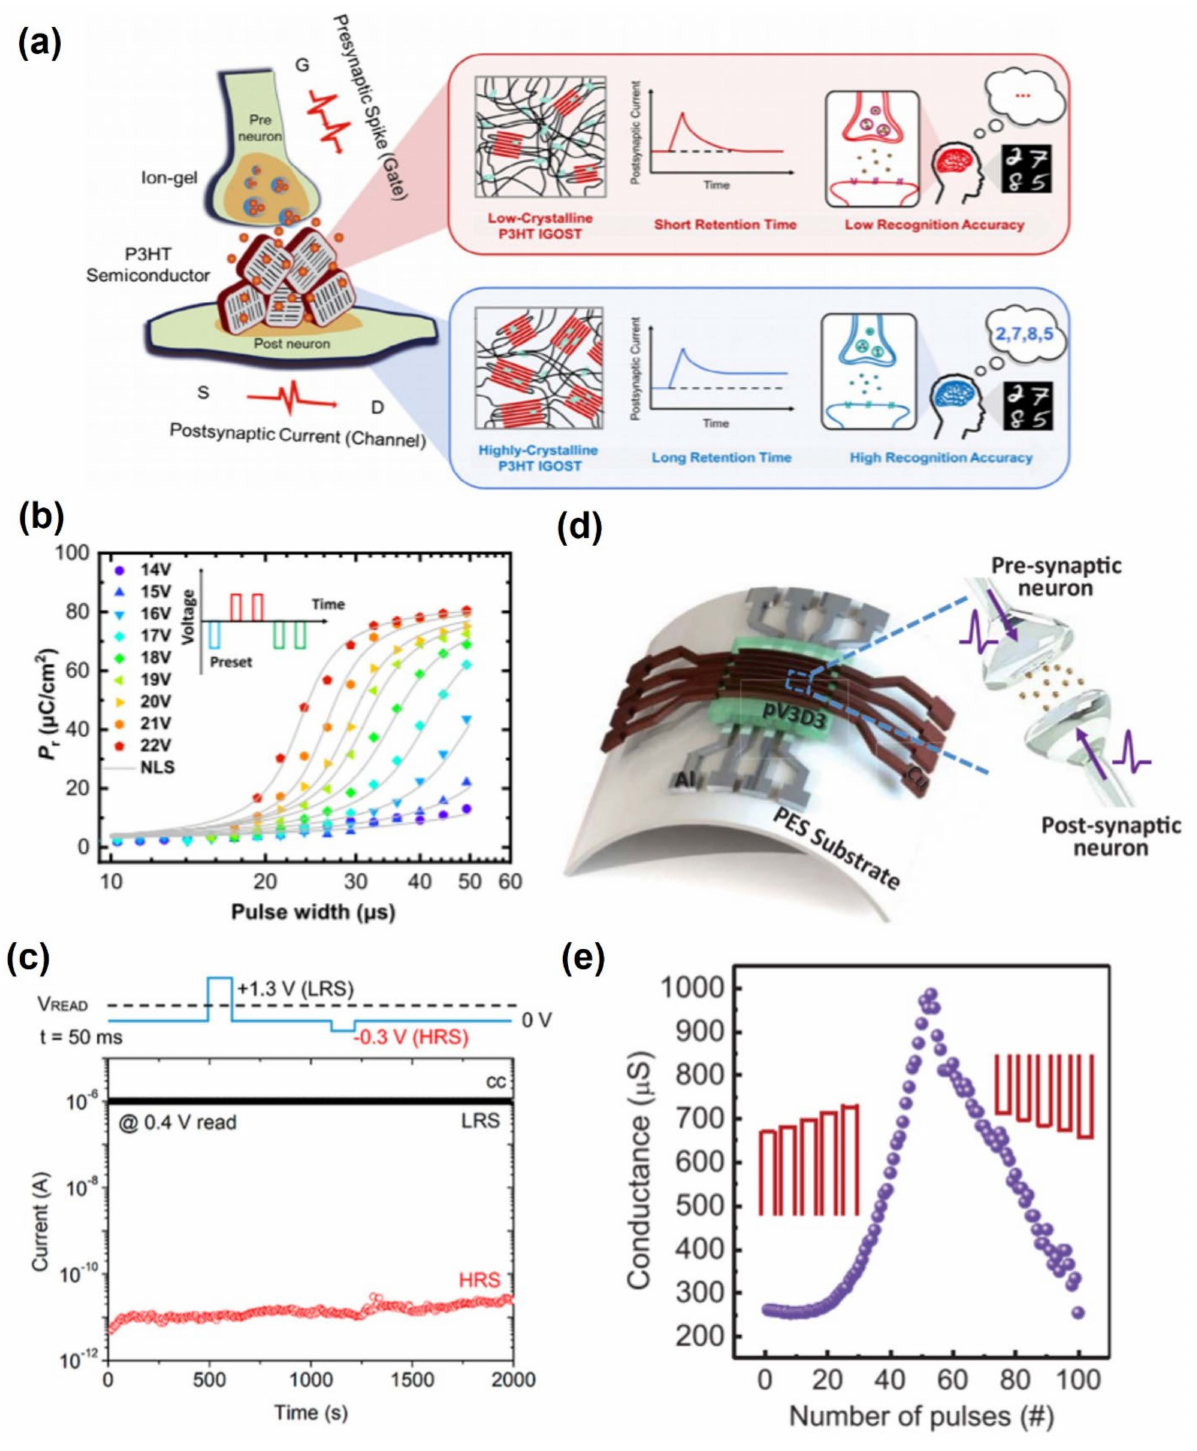
Figure 8. ( a ) Schematic diagram of the principle of the neuromorphic behavior using ions (adapted from [113] with permission from John Wiley and Son), ( b ) using ferroelectric polymer-based materials and its behavior according to the voltage (adapted from [114] with permission from the American Chemical Society), ( c ) ambipolar neuromorphic device and its operation mechanism (adapted from [115] with permission from the American Chemical Society), ( d ) flexible neuromorphic device using PV3d3 (adapted from [99] with permission from the American Chemical Society), and ( e ) conductance according to pulses using PV3d3 (adapted from [99] with permission from the American Chemical